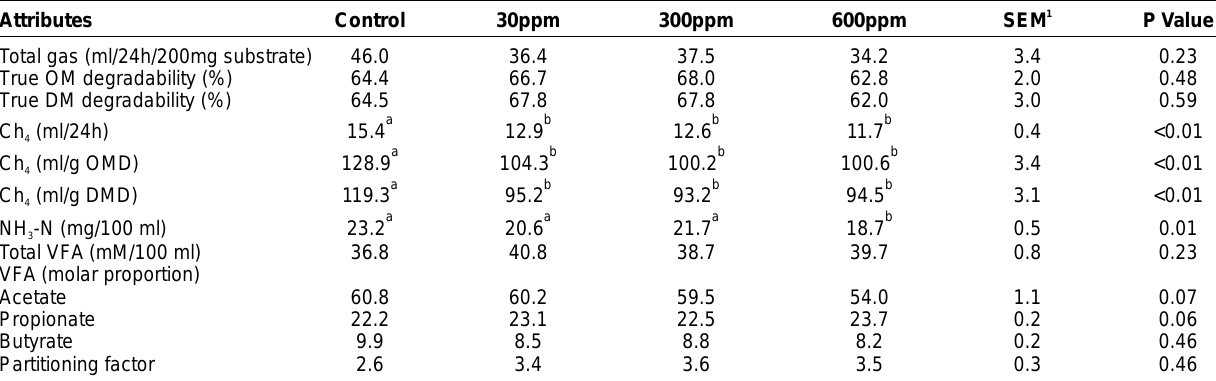
Table-5: Effect of different levels of rosemary oil on in vitro fermentation in wheat straw based (Concentrate: Roughage= 50:50)